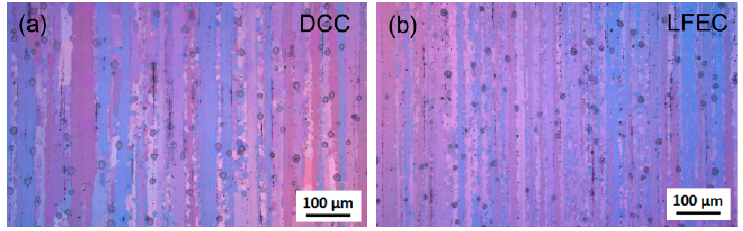
Figure 11. Micro-structure of 5A90 as-aged alloy: ( a ) DCC; ( b ) LFEC.